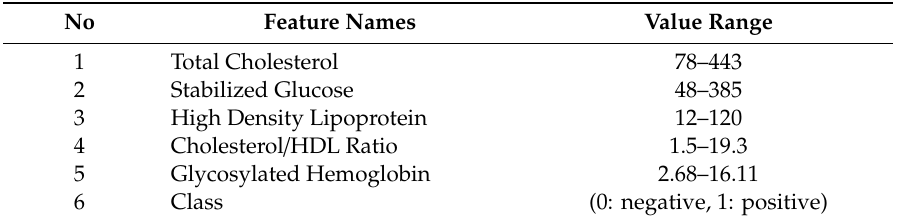
Table 2. Diabetes data summary.